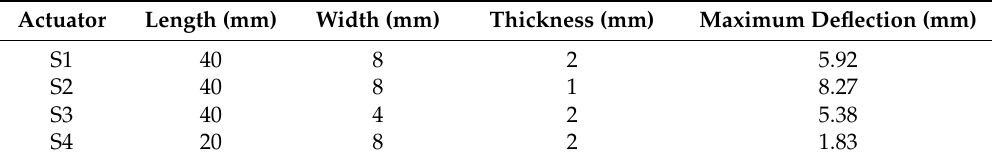
Table 1. The results of maximum endpoint deflection for the same pattern and different sizes of 3D-printed